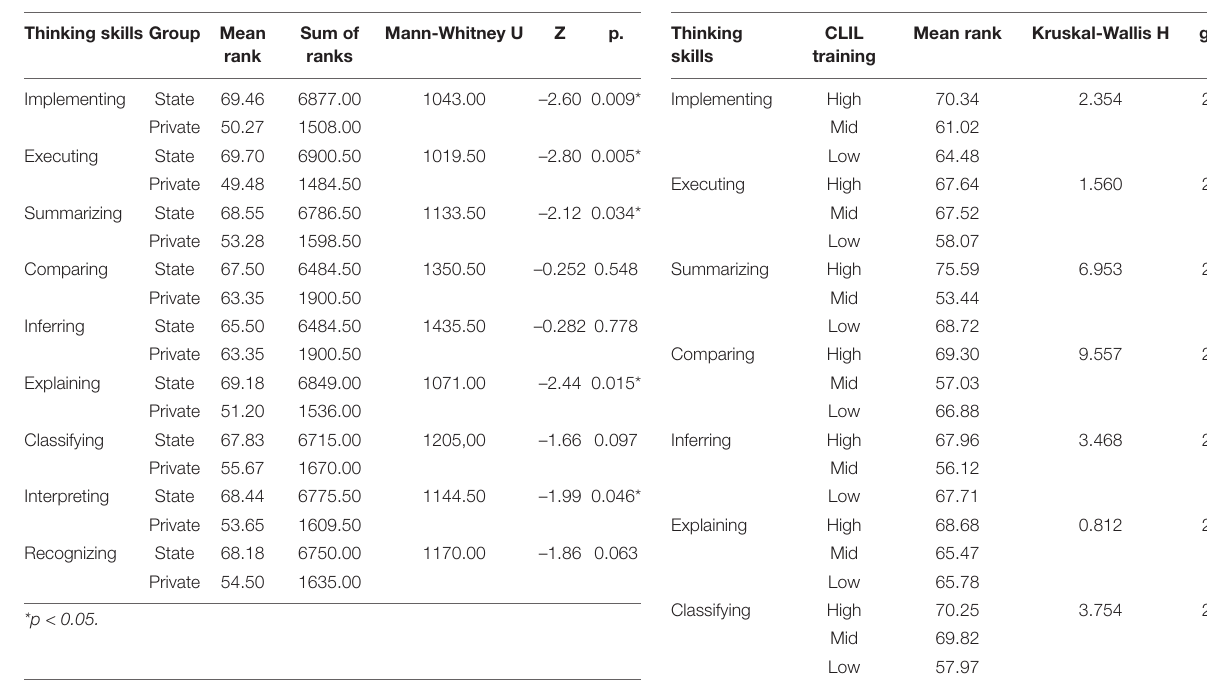
TABLE 4 | Non-parametric results for the practice of cognitive processes by gender. Thinking skills Group Mean